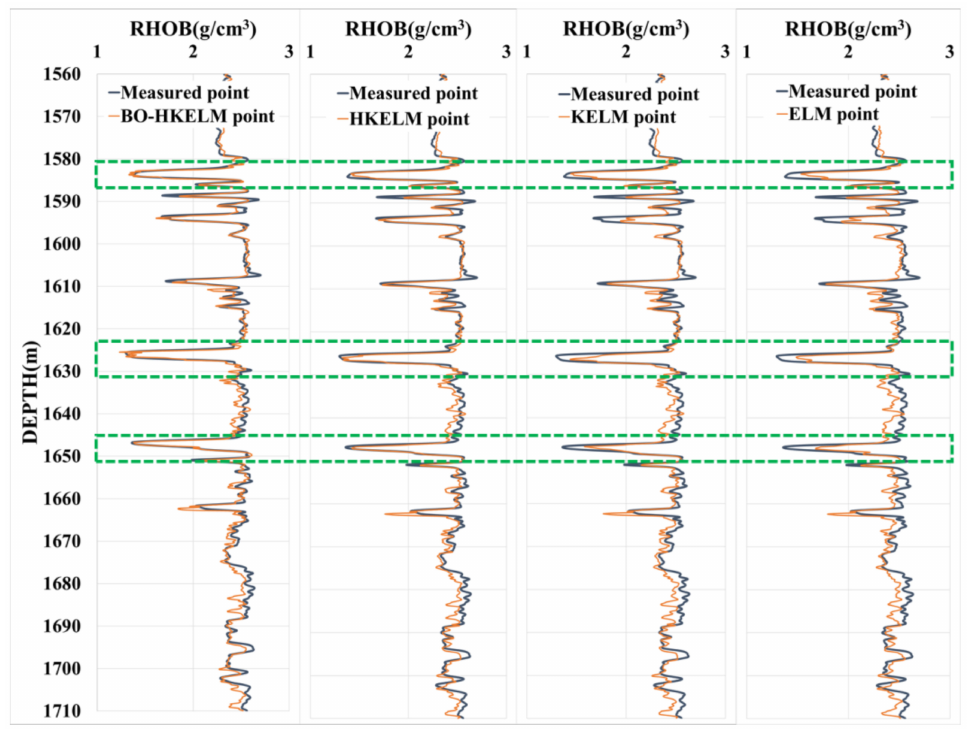
Figure 7. Visual results of the RHOB prediction results of Well A2.